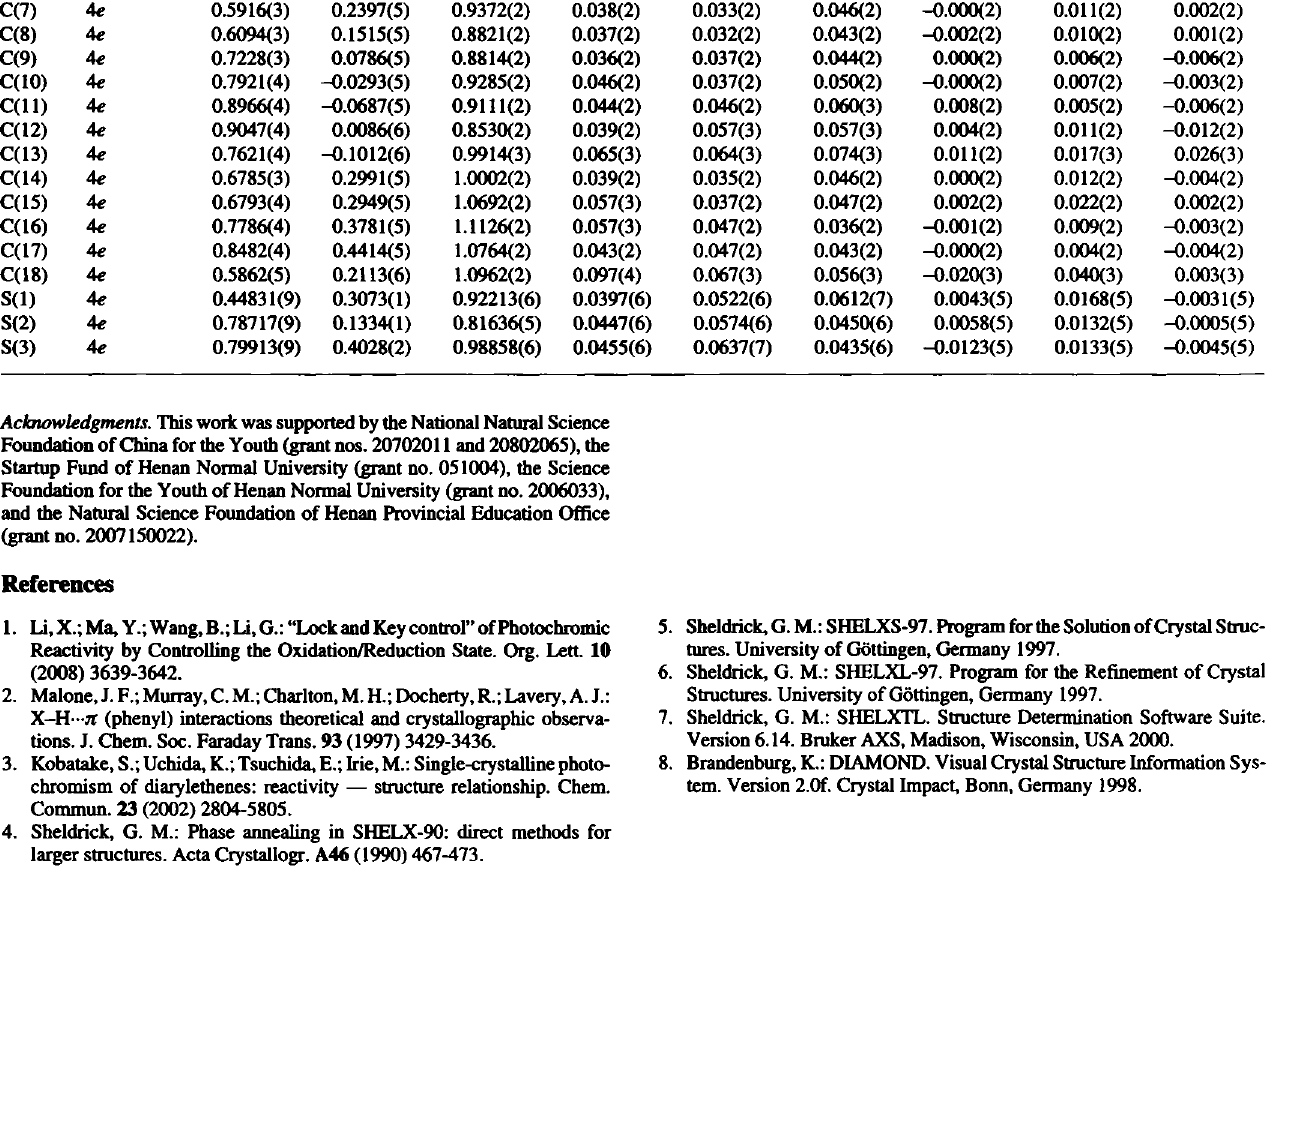
Table 3. Atomic coordinates and displacement parameters (in Â 2